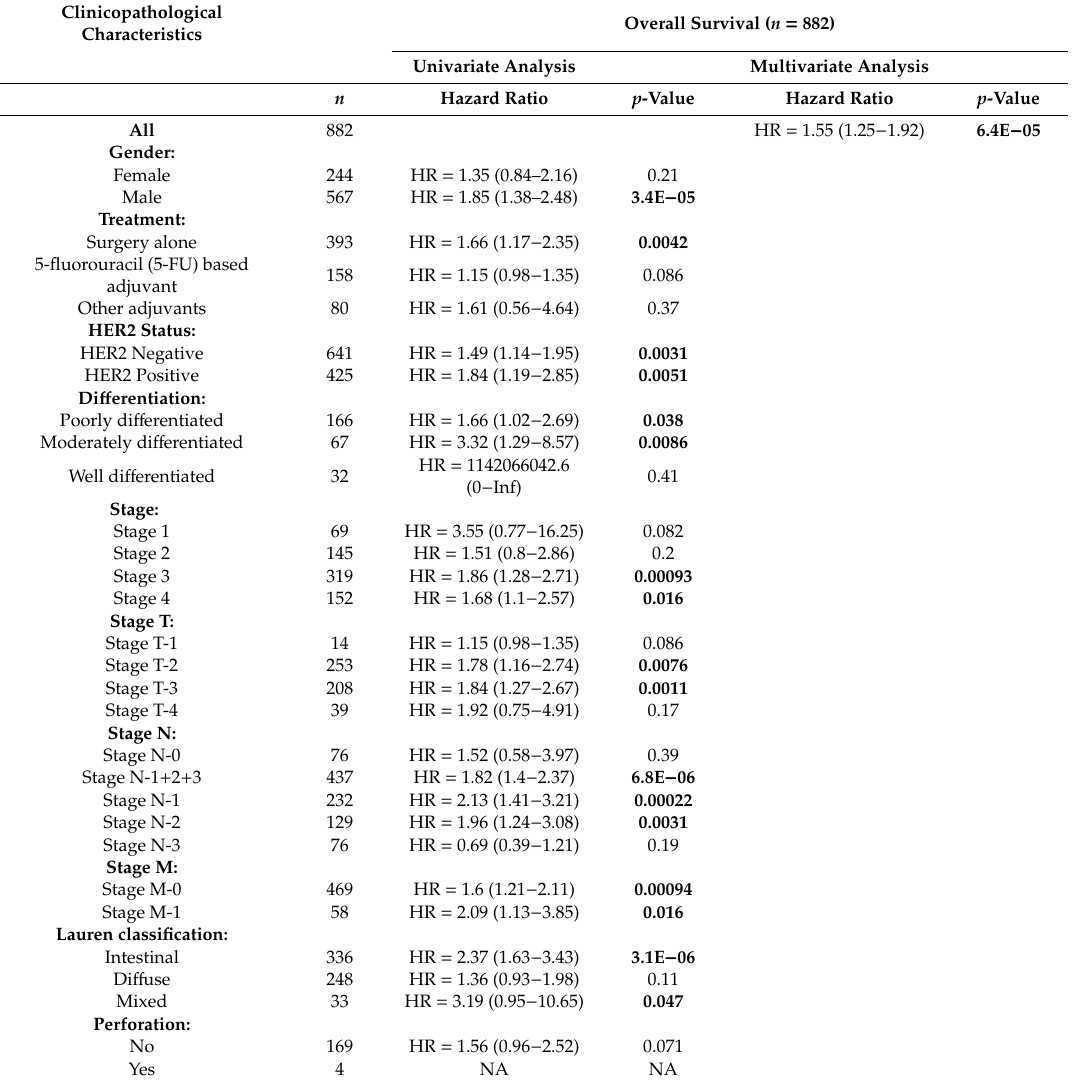
Table 2. Correlation of TTYH3 mRNA expression and clinical prognosis in gastric cancer with di ff erent clinicopathological factors by Kaplan–Meier plotter (univariate and multivariate analysis). Clinicopathological Overall Survival ( n = 882) Characteristics Univariate Analysis Multivariate Analysis n Hazard Ratio p -Value Hazard Ratio p -Value